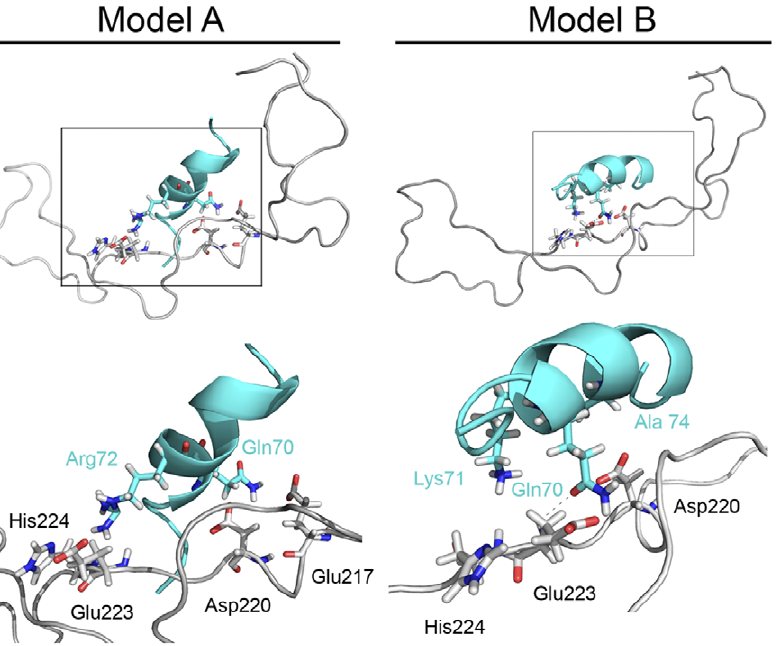
Figure 3. SE-CRT docking models. Graphic representation of the two most significant docking models shown in Table 1: Model A (left) and Model B (right). Closer views of the interactions between CRT (black font) and SE (cyan font) residues are shown in the lower panels.